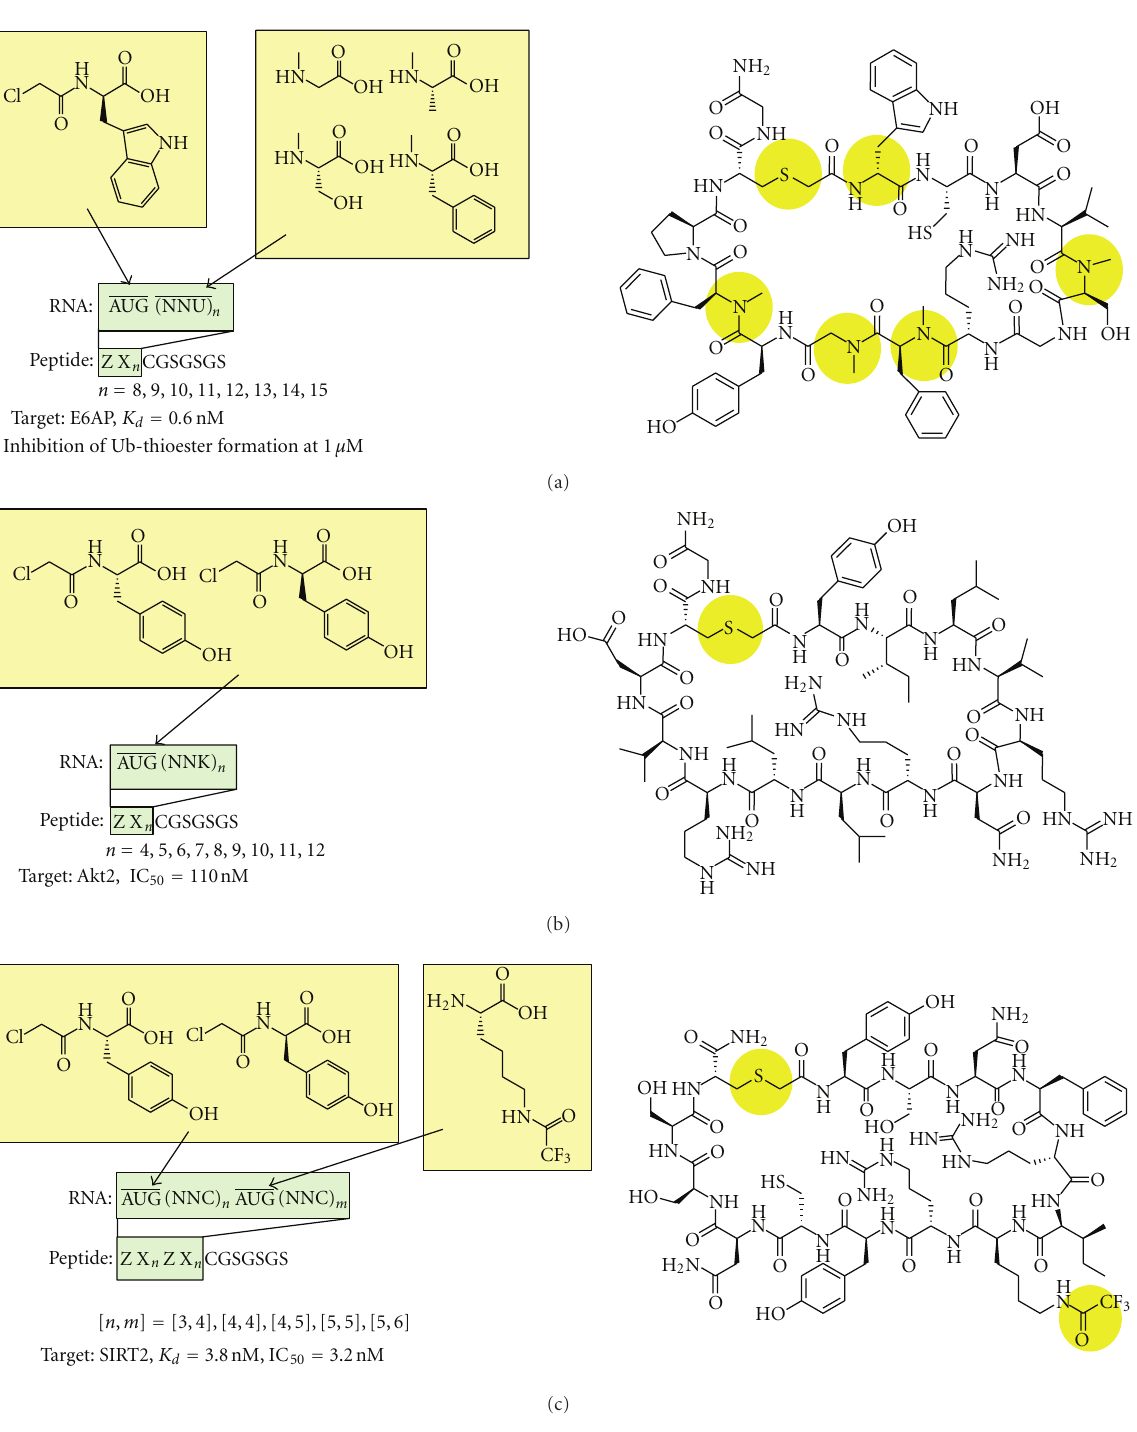
Figure 4: Selection of nonstandard peptides from libraries generated by flexizyme-based genetic code reprogramming. The flexizyme system was used to acylate tRNAs with nonproteinogenic amino acids. The nonstandard peptide libraries were expressed in a reconstituted cell-free translation system in the mRNA display format. (a)Selection of cyclic N -methyl-peptides against E6AP. N -Chloroacetyl-D-tryptophan was reassigned to AUG, and four N -methyl-L-amino acids were independently reassigned to one of the NNU codons. (b)Selection of thioether- cyclized peptides against Akt2. Each enantiomer of N -chloroacetyltyrosine was reassigned to the initiation AUG codon. (c)Selection of cyclic peptides containing N -6-trifluoroacetyl-L lysine against sirtuin 2 (SIRT2). Each enantiomer of N -chloroacetyl-tyrosine was reassigned to the initiation AUG codon and N -6-trifluoroacetyl-L-lysine ( CF3 K) was reassigned to the elongation AUG